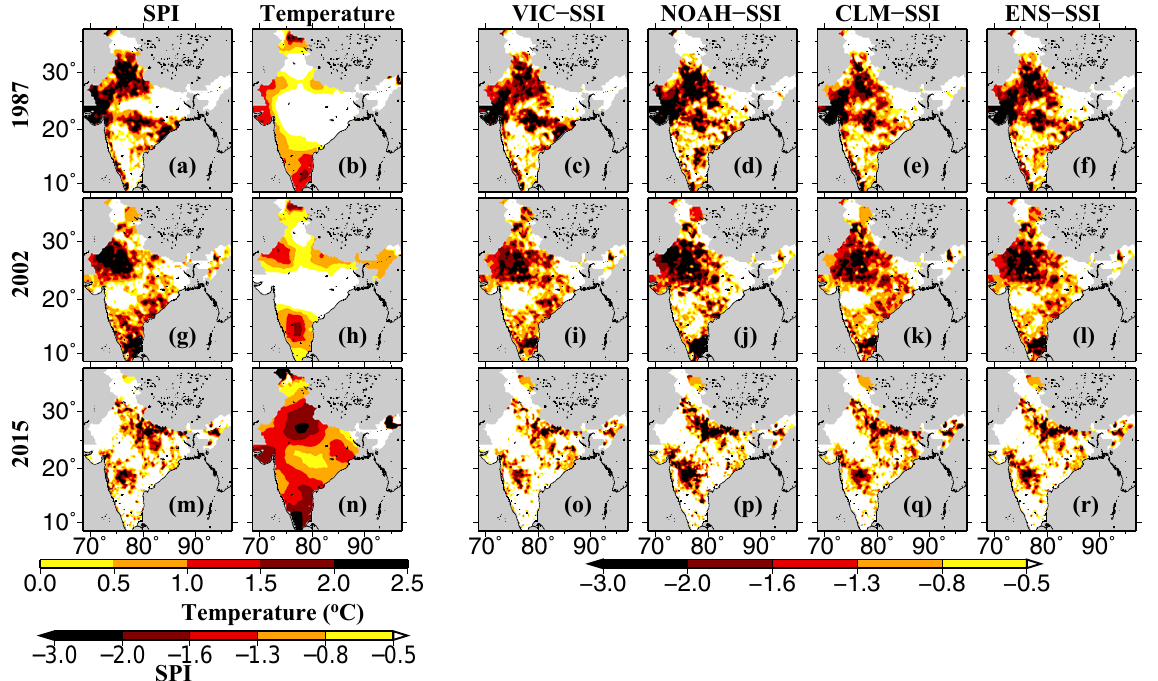
Figure 4. Reconstruction of monsoon season drought events of (a–f) 1987, (g–l) 2002, and (m–r) 2015, estimated based on (a, g, k) the 4-month SPI at the end of the monsoon season, (c, i, o) the 4-month SSI at the end of the monsoon season simulated using the VIC model, (d, j, p) same as (c, i, o) but for the Noah model, and (e, k, q) same as (c, i, o) but for the CLM. (f, l, r) Ensemble mean 4-month SSI simulated using the VIC, Noah, and CLM. (b, h, n) Air temperature anomaly during the monsoon season for the selected drought